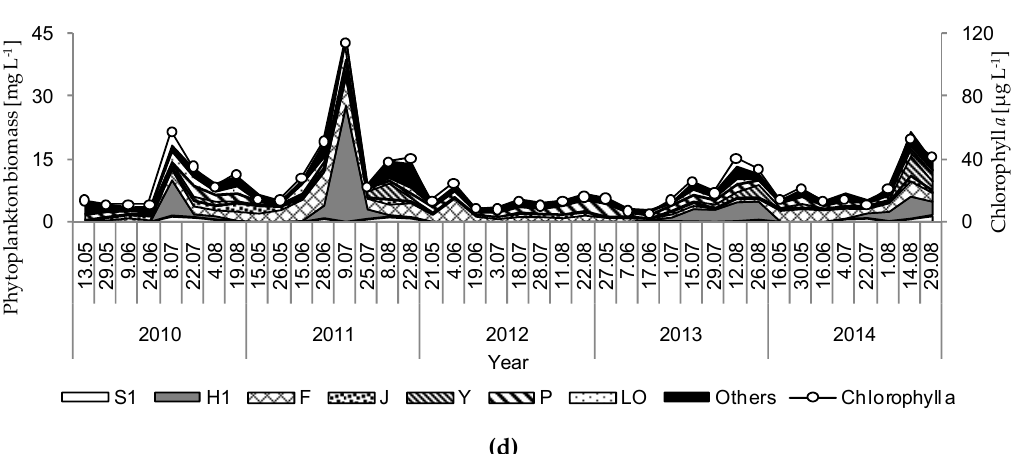
Figure 4. Temporal variation in the biomass of different phytoplankton functional groups and the concentration of chlorophyll a during the investigation period (2010–2014) in the studied lakes: ( a ) G Łę bokie; ( b ) Gumienek; ( c ) Czarne; ( d ) Ma ś luchowskie. Explanations: S1—cyanobacteria of turbid mixed layers; H1—dinitrogen-fixing nostocaleans; F—chlorophytes of clear epilimnion; J—chlorophytes of shallow enriched lakes; Y—cryptomonads of small enriched lakes; P—chlorophytes of eutrophic epilimnion; Lo—various species typical of summer epilimnion in mesotrophic lakes.